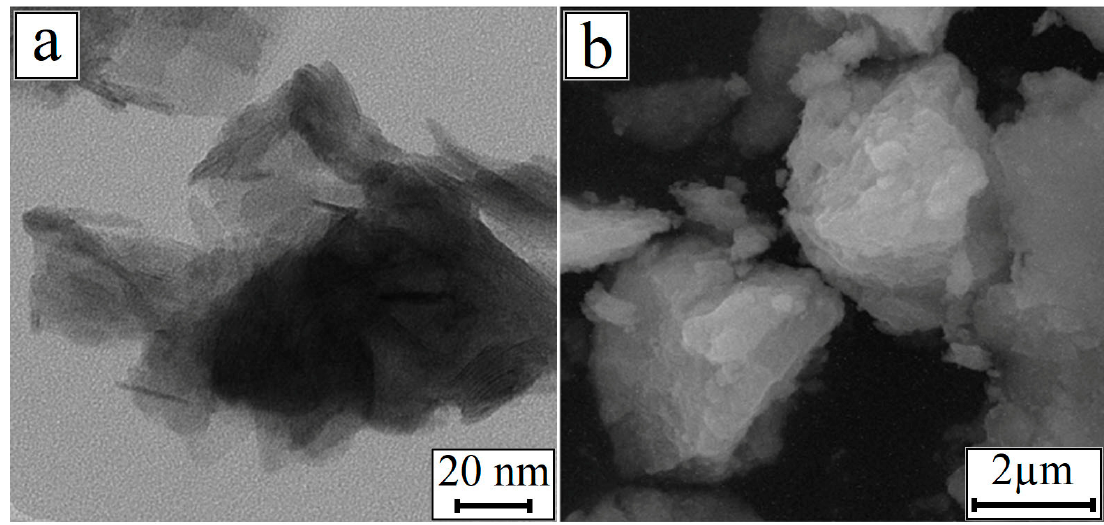
Figure 5. Nickel hydroxide microstructure: ( a ) TEM of Ni(OH) 2 _20;10;c and ( b ) SEM of Ni(OH) 2 _20;9;u. Table 3. Calculated parameters of the nickel hydroxide aggregate.